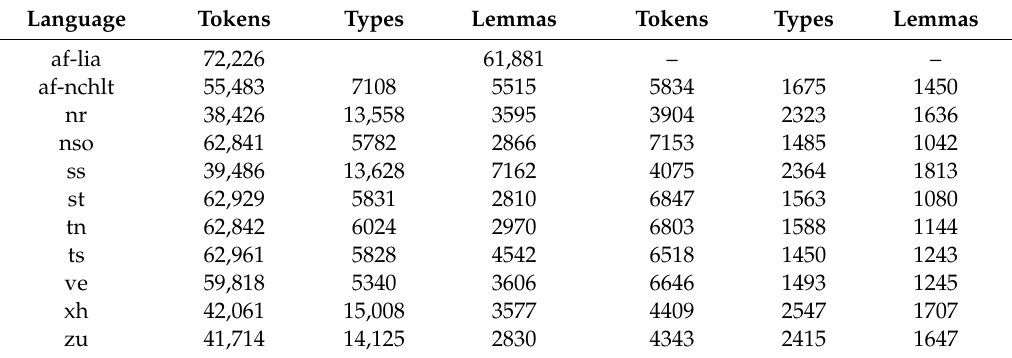
Table 2. Train and test data statistics for